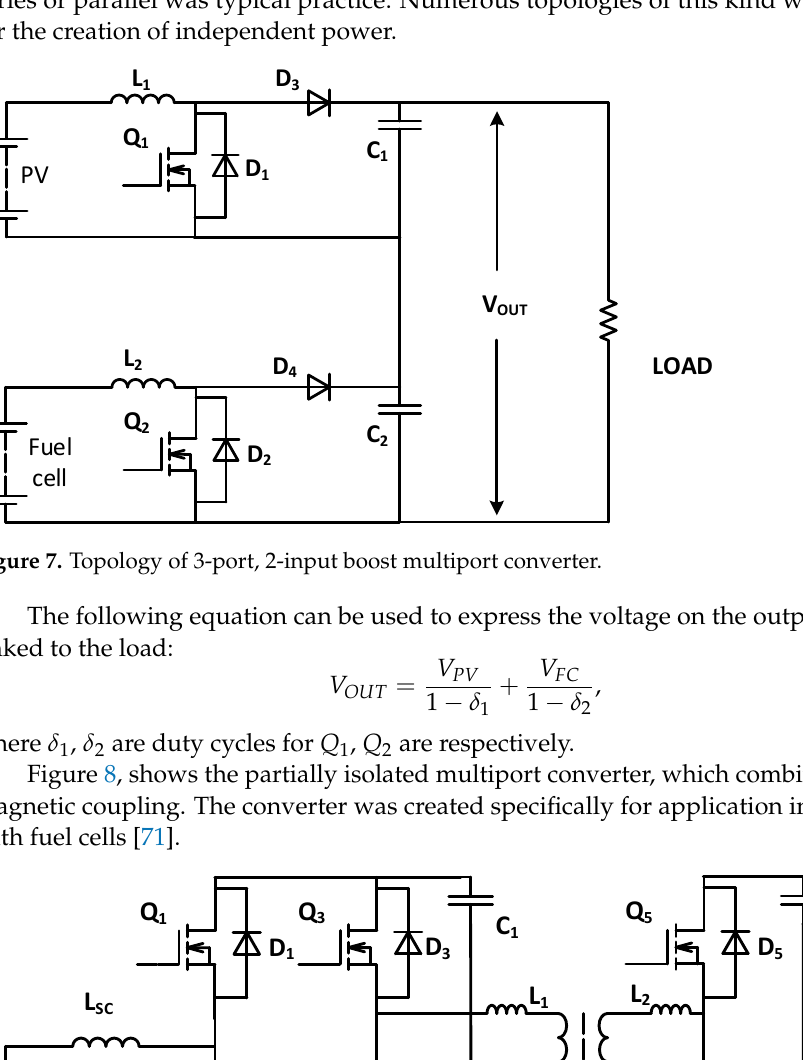
Figure 8. Topology of 3-port, 2-input boost multiport converter.